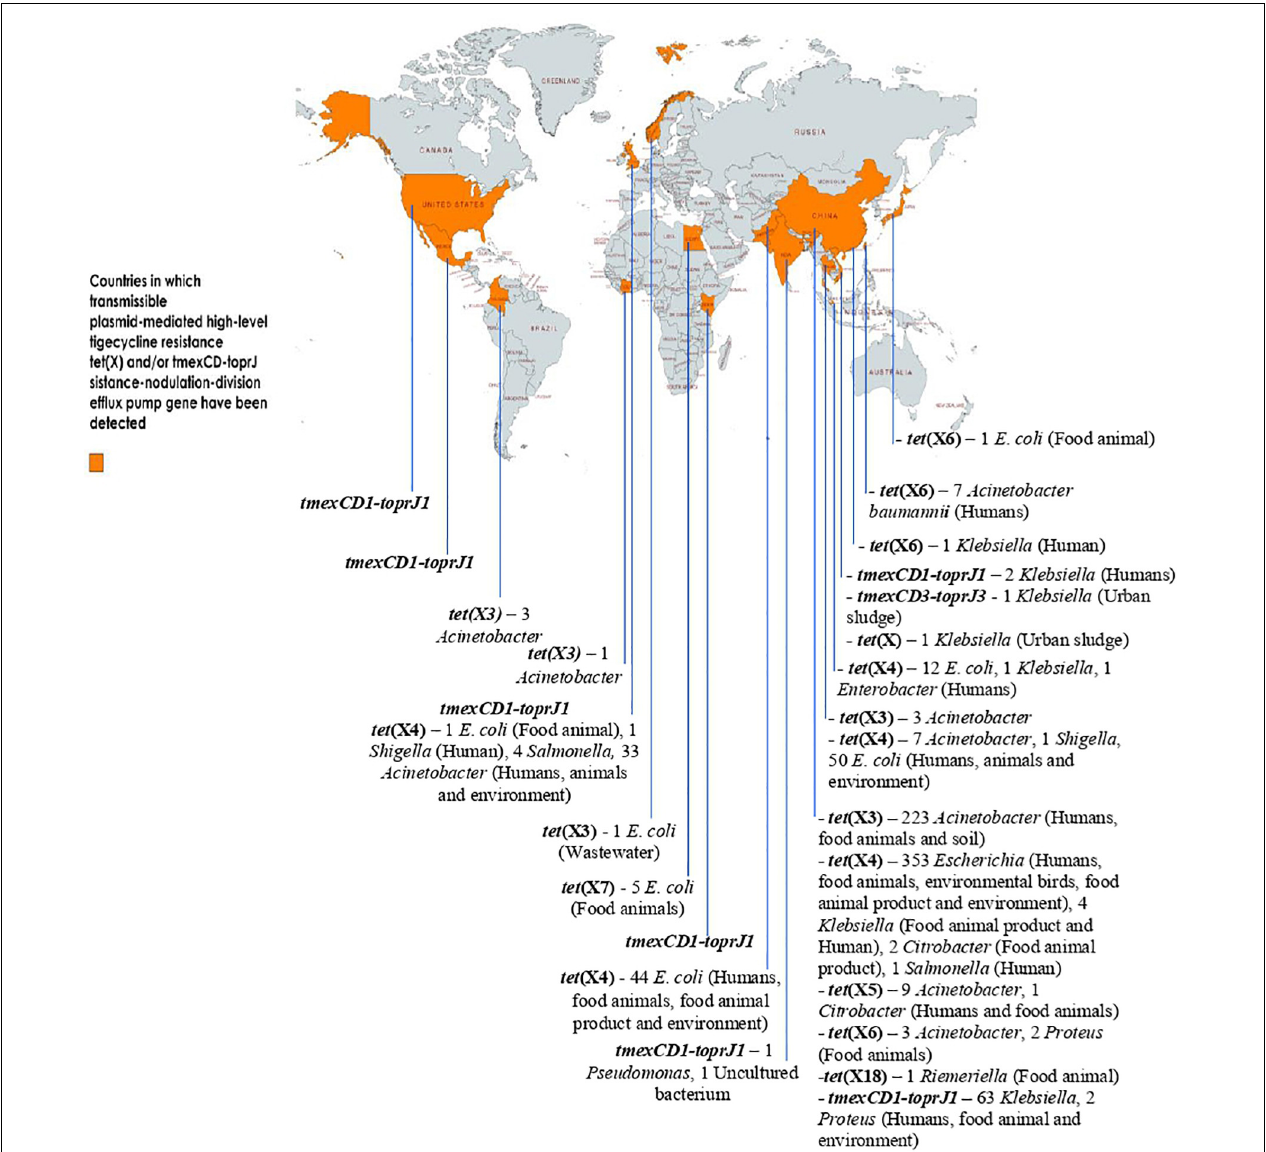
FIGURE 2 | Distribution of plasmid-encoded high-level tigecycline resistance gene-harboring organisms in diverse ecological niches worldwide. The data set for some of the genes (with or without ecological niches) was based on data mining from the NCBI database by Fang et al. (2020), Peng et al. (2021), and Wang et al. (2021e) This map was created using an online service